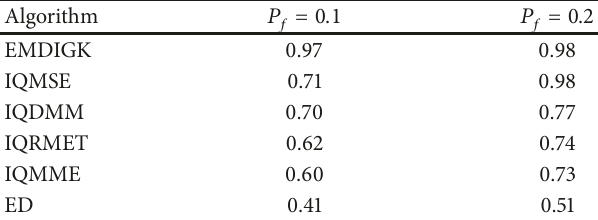
Table 2: The 𝑃 𝑑 of different methods in 𝑆𝑁𝑅 = −14 dB.